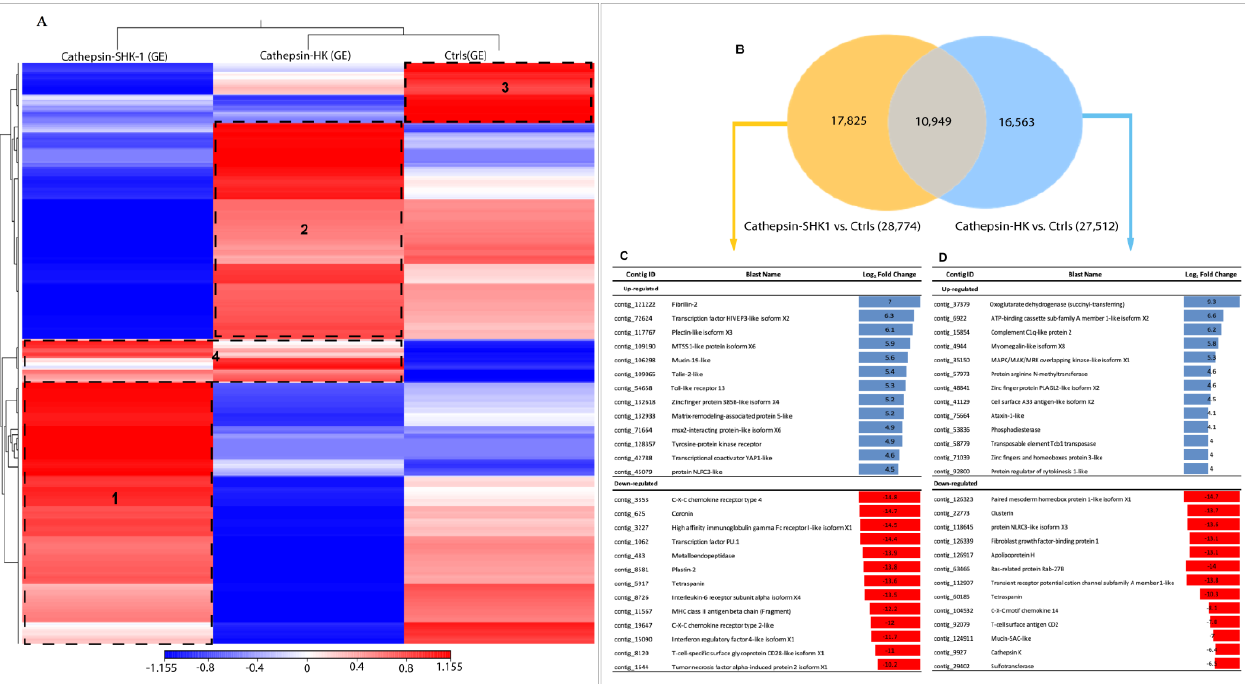
Figure 1. Transcriptome profiling of mRNA from the SHK-1 cell line and salmon head kidney (HK) exposed to recombinant Cr-cathepsin. ( A ) Heatmaps for each treatment were constructed with the TPM (transcripts per million of reads) values of mRNAs and grouped by hierarchical clustering based on the Manhattan distance with average linkages. A red color indicates up-regulated mRNAs, and blue represents down-regulated transcripts. ( B ) Top-20 DEGs expressed in SHK-1 vs. control. ( C ) Venn diagrams of DEGs among tissues (SHK-1 cell line and HK exposed to Cr-cathepsin) vs. control group (|fold change| > 4, p -value < 0.05). Up/down-regulated transcripts were calculated from the comparisons between the SHK-1 cell line vs. control (17,825 transcripts), HK vs. control (16,563 transcripts), and shared (10,949 transcripts). ( D ) Top-20 DEGs in HK vs. control.